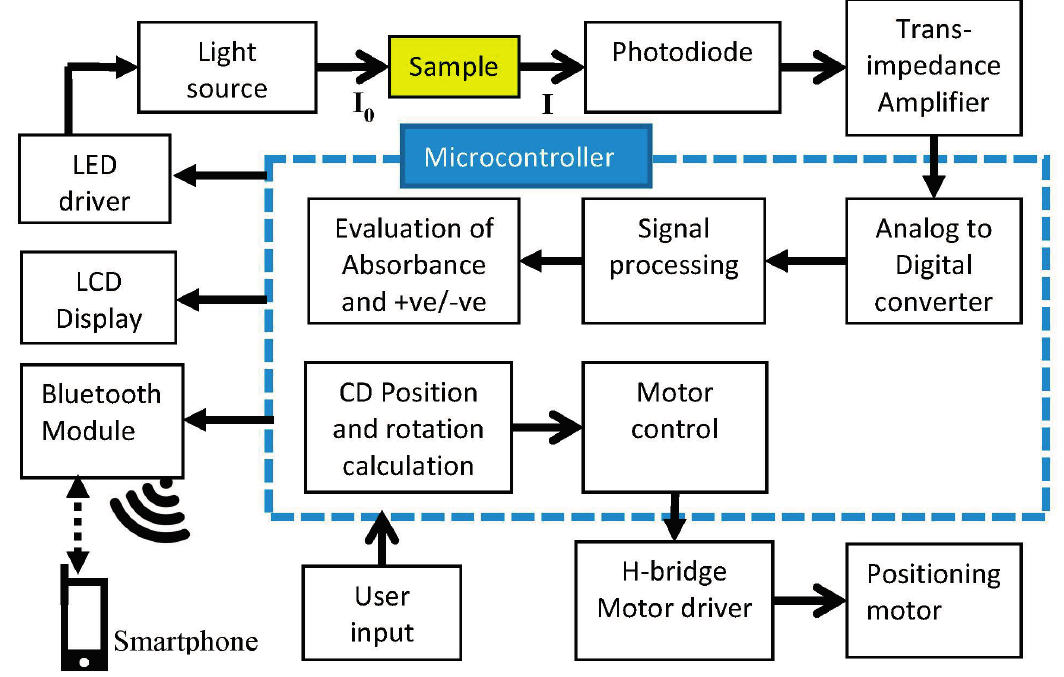
Figure 2. Block diagram of Colorimetric Enzyme-Linked Immunosorbent Assay (ELISA) detection platform for a Lab-on-a-Compact-Disc (LOCD)